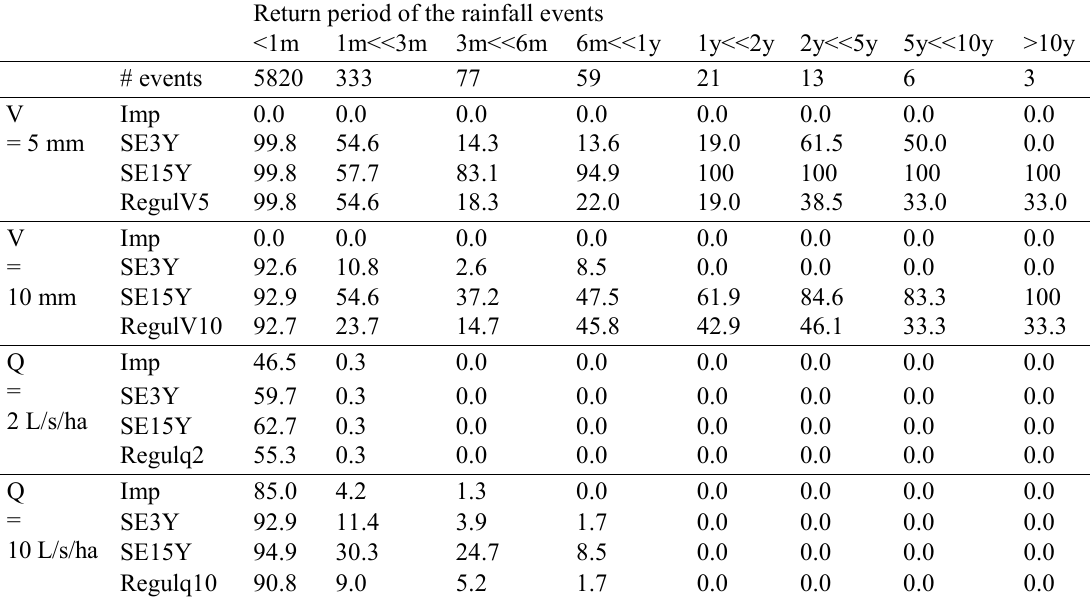
Table 1 Ratio (expressed in %) of rainfall events for which the regulation rule is respected depending on the infrastructure implementation and the return period of the rainfall